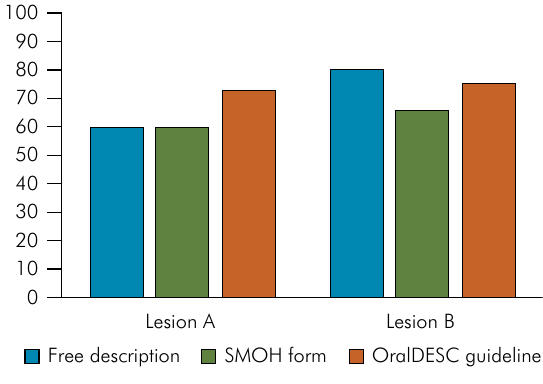
Figure 4. Comparison between average agreement for items essential for setting priorities for lesions A and